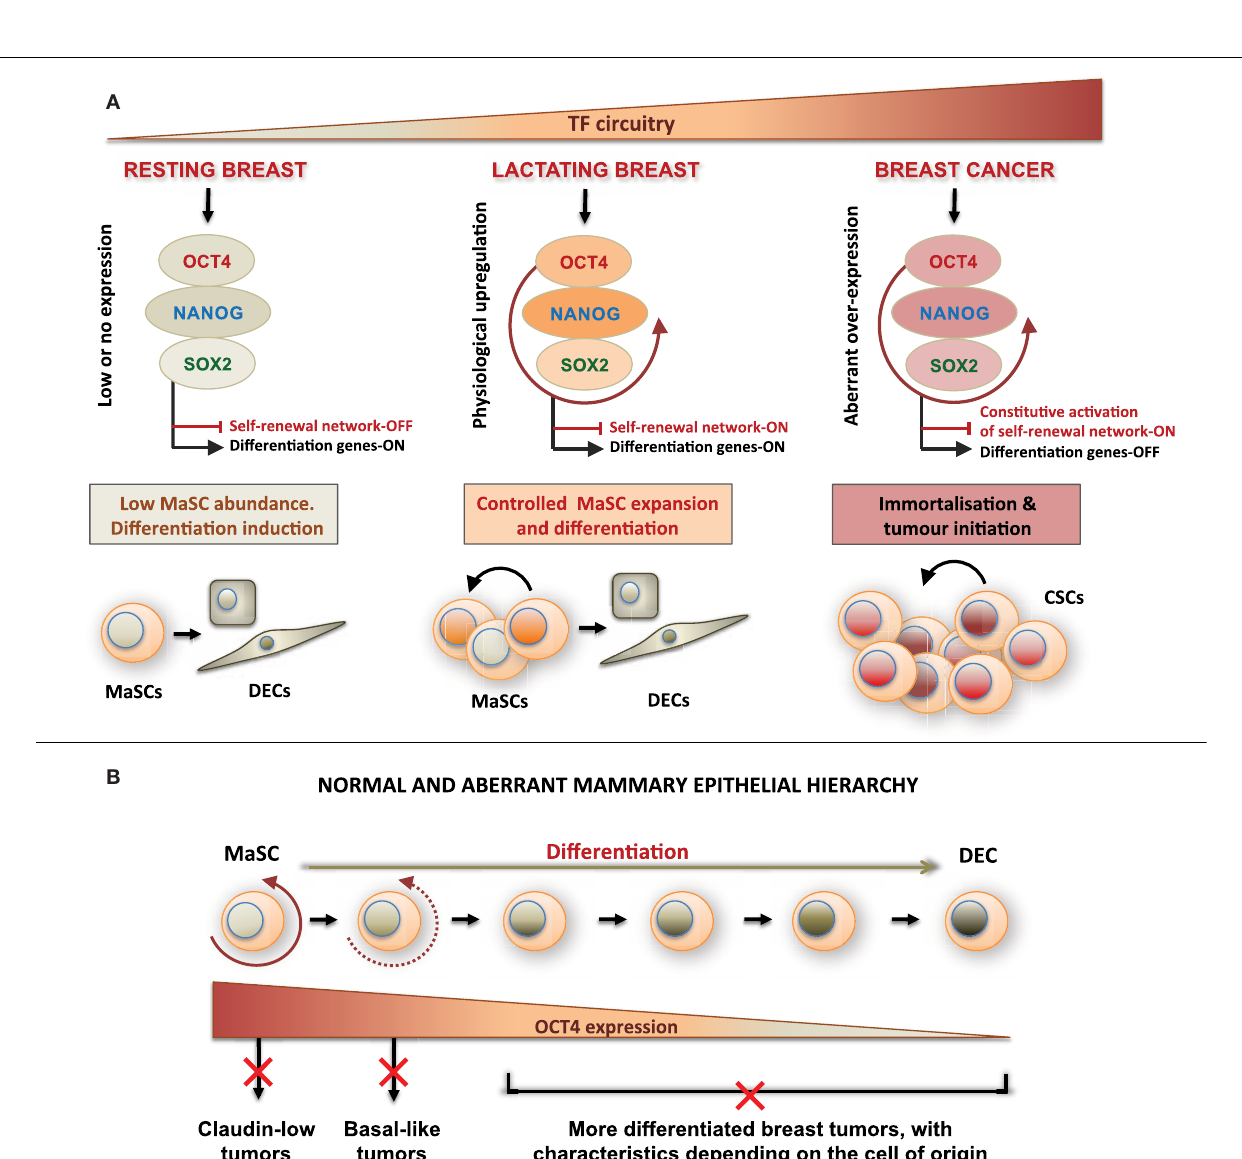
differentiation. Uncontrolled overexpression of OCT4 and/or its associated ESCTFs leads to oncogenic activation ofTFs, transformation, and aberrant expansion of the target cell, which may be a MaSC or a more differentiated cell, and acquisition of a CSC phenotype. (B) Normal and aberrant mammary epithelial hierarchy based on changing expression of OCT4 that determines the cell state in a mammary developmental continuum. Deregulation of OCT4 expression at each developmental state results in cell transformation and generation of different tumor subtypes. DECs, differentiated epithelial cells; CSCs, cancer stem